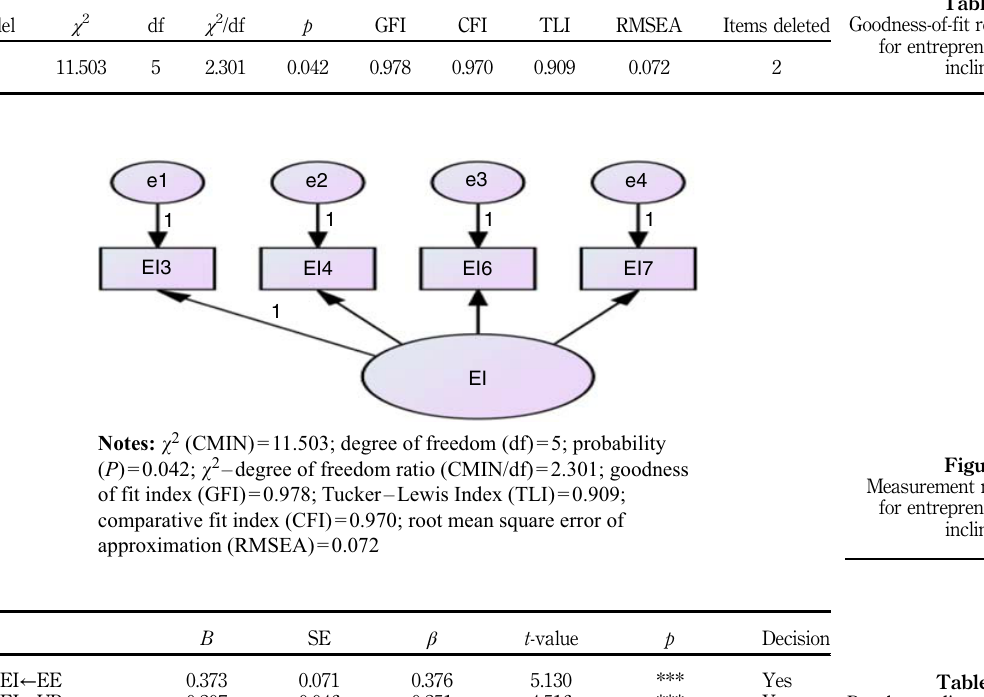
Table VII. Results on direction of relationship